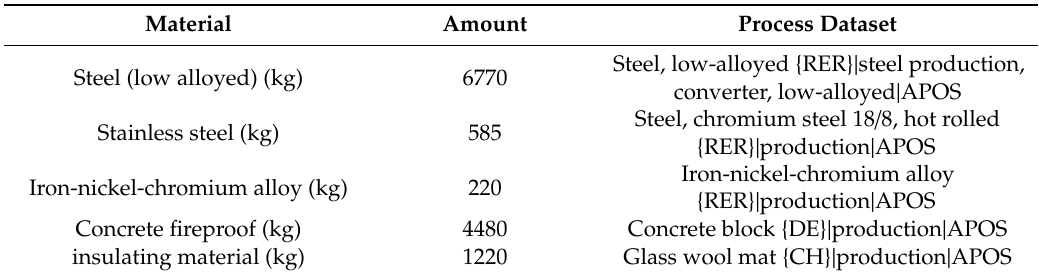
Table 3. Materials of the gasifier including the primary gas treatment